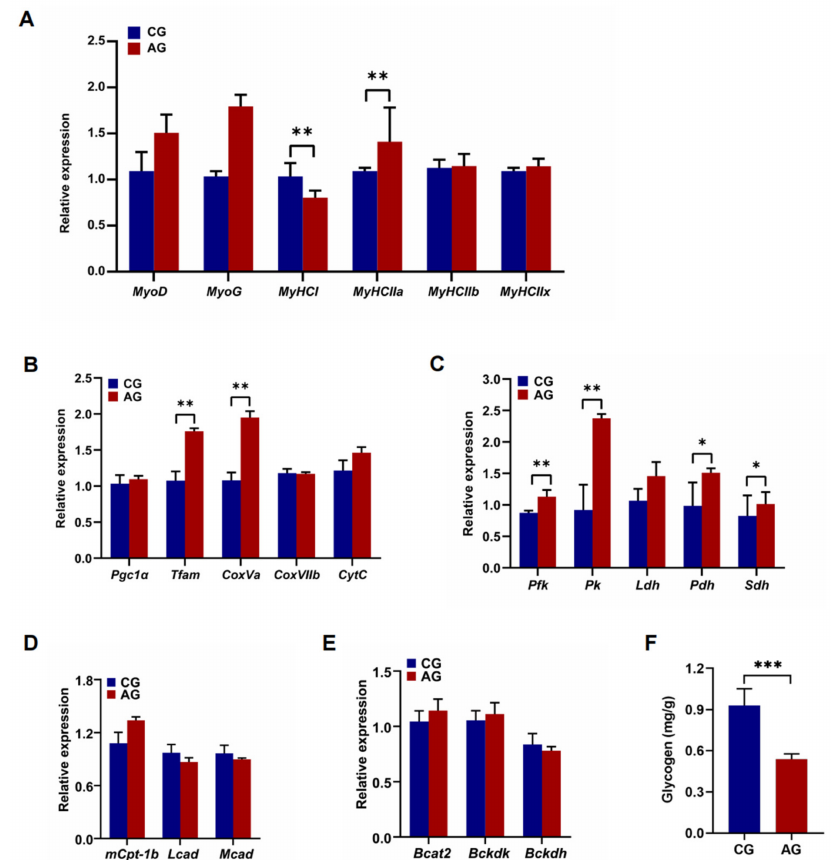
Figure 7. Gene expression in quadriceps femoris (QF) of mice. ( A ) The expression of the skeletal muscle-specific transcription factors, MyoD and MyoG genes, which encode myosin heavy chain ( MyHC ) isoforms, namely, the MyHC I , MyHC IIa , MyHC IIb , and MyHC IIx genes in the QF of CG and AG mice. ( B ) The expression of the PGC-1 α , Tfam , CoxVa , CoxVIIb , and Cyt c genes related to mitochondrial function in the QF of CG and AG mice. ( C ) The expression of the Pfk , Pk , Ldh , Pdh , and Sdh genes, which are involved in glucose metabolism in the QF of CG and AG mice. ( D ) The expression of the mCpt-1b , Lcad , and Mcad genes involved in the fatty acid oxidation pathway in the QF of CG and AG mice. ( E ) The expression of the Bcat2 and Bckdk genes involved in branched-chain amino acid catabolism in the QF of CG and AG mice. ( F ) The concentration of glycogen in the QF of CG and AG mice. Data are expressed as mean ± SEM. * p < 0.05, ** p < 0.01, and *** p <